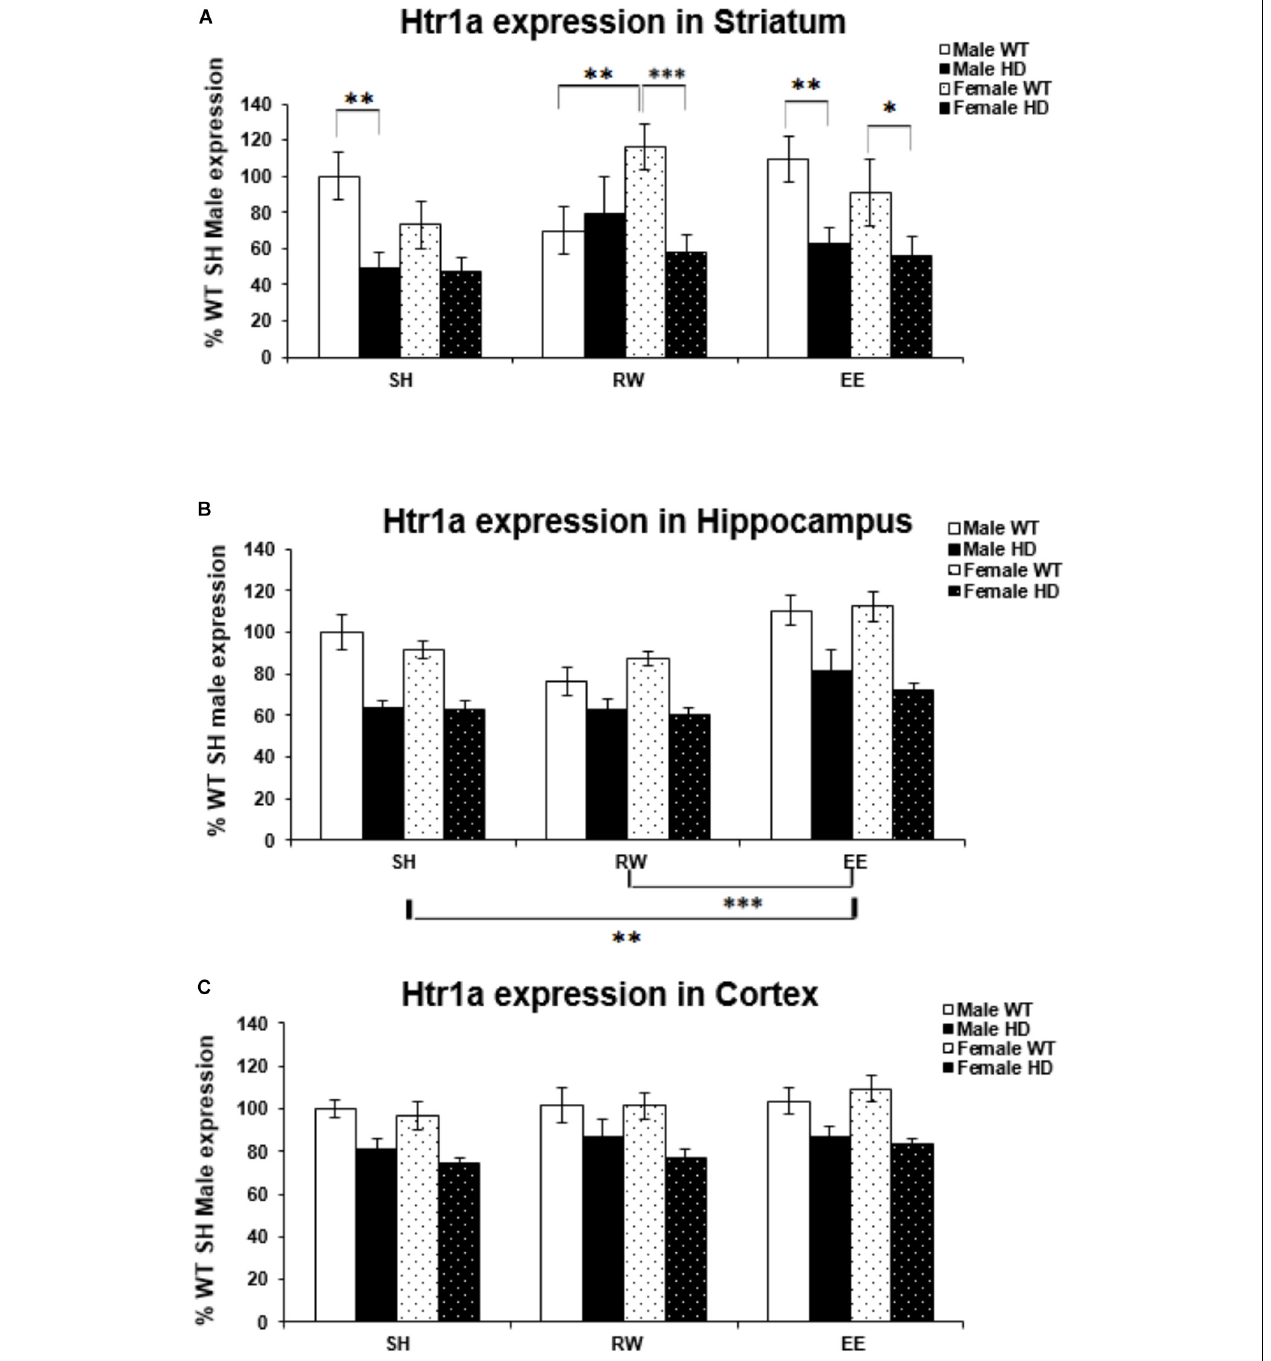
FIGURE 2 | Effects of genotype, environment and sex on Htr1a mRNA levels in 8-week-old WT and HD mice. (A) In Striatum, Htr1a expression was decreased significantly in 8-week-old HD mice compared to their WT counterparts ( p < 0.001). There was a significant interaction between genotype × housing environment × sex ( p = 0.021). Pairwise comparisons showed significant differences in Htr1a expression between male and female WT mice exposed to wheel running ( p = 0.009), between female HD and WT exposed to EE ( p = 0.044) and RW ( p = 0.001) and between male HD and WT mice exposed to SH ( p = 0.004) and EE ( p = 0.008). (B) In Hippocampus, Htr1a expression was reduced significantly in 8-week-old HD mice ( p < 0.001). Housing environment had a significant effect on Htr1a expression ( p < 0.001). Post hoc testing showed that environmental enrichment ( p = 0.002), but not wheel running ( p = 0.214), significantly increased levels of Htr1a mRNA. (C) In Cortex, Htr1a expression was decreased significantly in 8-week-old HD mice compared to their WT counterparts ( p < 0.001). Housing environment had no effect on Htr1a expression ( p = 0.150). n = 4–6 per group. Results are represented as mean ± SEM. Pairwise comparisons were conducted using Bonferonni’s adjustment for multiple comparisons: ∗ p < 0.05; ∗∗ p ≤ 0.01; ∗∗∗ p ≤ 0.001.